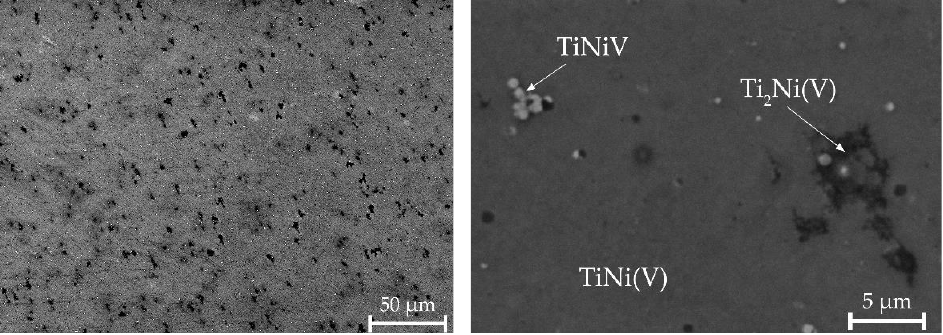
Figure 8. Microstructure of alloy No. 3. Table 3. Quantitative elemental composition of the structural components of alloy No. 3. Structural